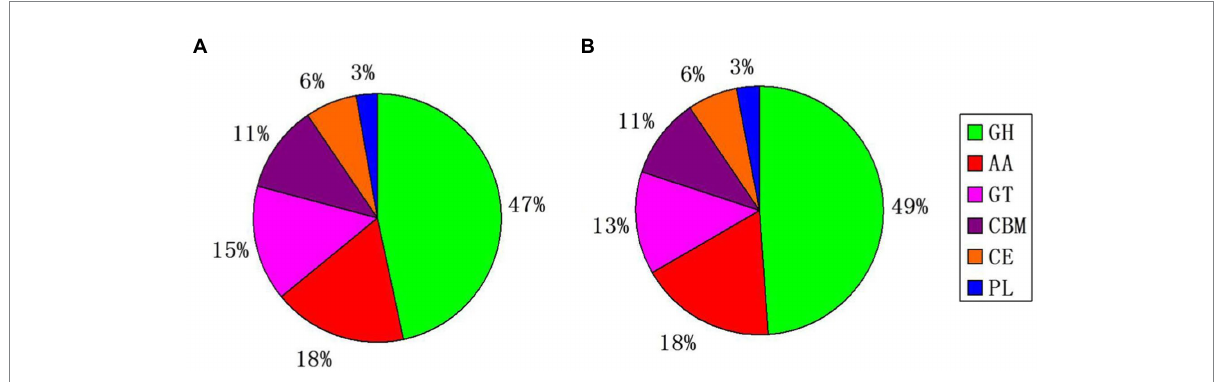
FIGURE 2 Classification and comparison of the two formae speciales by using whole genome CAZy database. (A) Setosphaeria turcica f. sp. sorghi GD003. (B) S. turcica f. sp. zeae Et28A. GH, glycoside hydrolase; AA, auxiliary activity; GT, glycosyltransferase; CBM, carbohydrate-binding module; CE, carbohydrate esterase, and PL, polysaccharide